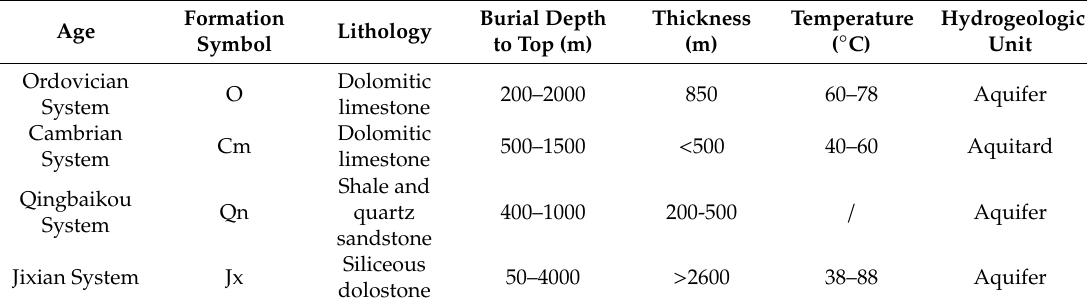
Table 1. Characteristics of the basement aquifers in the Beijing plain area.